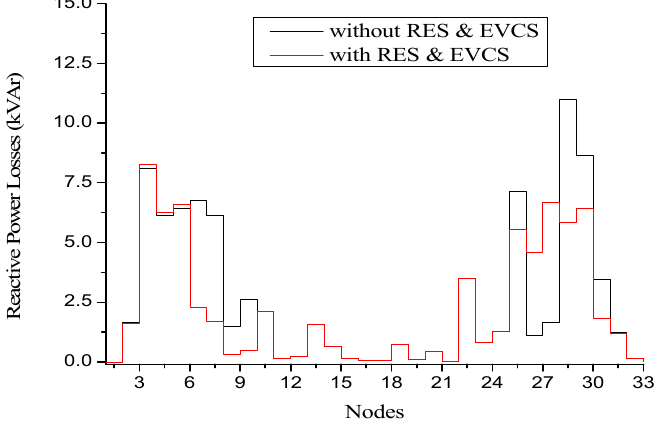
Figure 12. Reactive power losses with and without the integration of RES and EVCS.